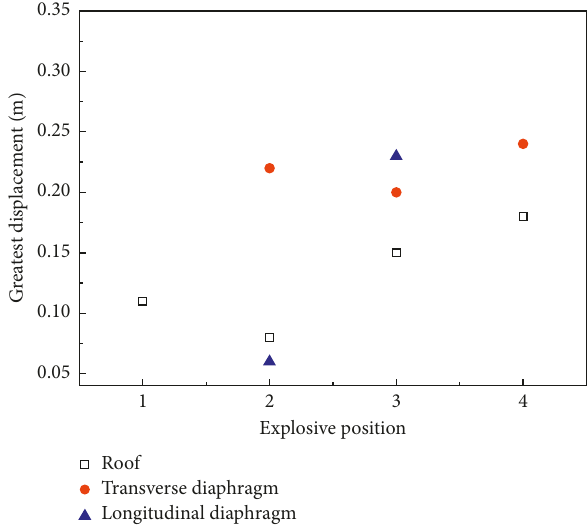
Figure 18: Greatest displacement of plates in different explosive